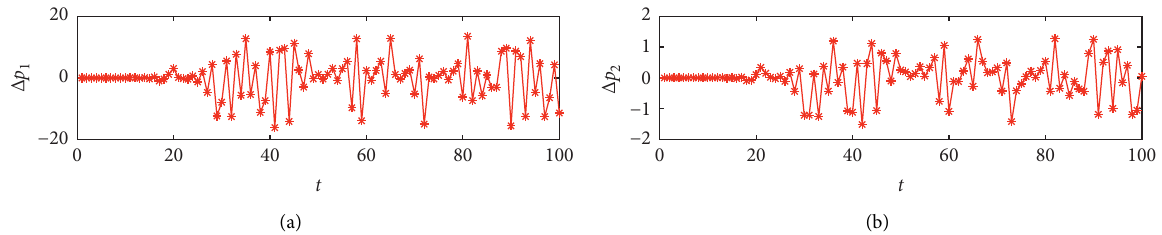
Figure 12: Sensitivity of dynamic system (15) to initial price values. (a) Δ p